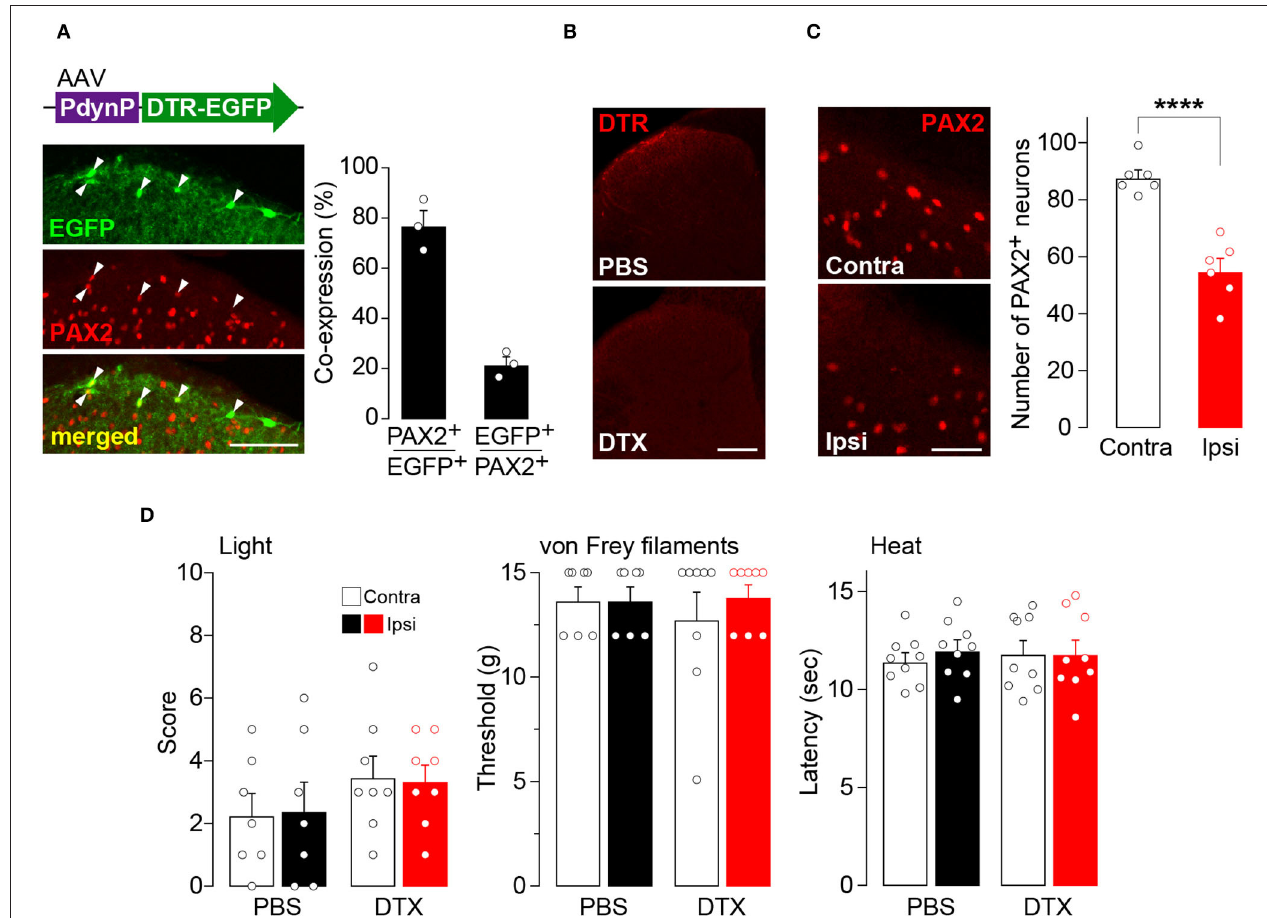
FIGURE 2 | Ablation of AAV-PdynP + spinal dorsal horn (SDH) neurons does not affect behavioral responses evoked by the optical stimulation of A β fibers, nociceptive mechanical force, and heat in rats. (A) Enhanced green fluorescent protein (EGFP) expression (green) in the L4 SDH at 4 weeks after intra-SDH microinjection of AAV-PdynP-DTR-EGFP (indicated by an upper schematic illustration). Colocalization of EGFP and PAX2 (red) in the SDH (indicated by arrowheads). Scale bar, 100 µ m. The percentage of co-expressing neurons was quantified ( n = 3 rats tested, 94 total EGFP + cells quantified, and 339 total PAX2 + cells quantified). (B) Diphtheria toxin receptors (DTR) immunofluorescence in the SDH after administration of diphtheria toxin (DTX: 50 µ g/kg, i.p., two injection 72h apart) or PBS. Scale bar, 200 µ m. (C) Immunohistochemical analysis and quantification of PAX2 + neurons in the superficial laminae of the ipsilateral and contralateral SDH at 4 weeks after DTX injection ( n = 6 rats tested, PAX2 + neurons: 992 [ipsi] and 1574 [contra] cells quantified). Scale bar, 50 µ m. **** P < 0.0001, Unpaired t -test. (D) Paw withdrawal behaviors by light (score), von Frey filaments (threshold), and heat (latency) at 4 weeks after DTX or PBS injection ( n = 7–9 rats). Data shown as mean ± SEM.